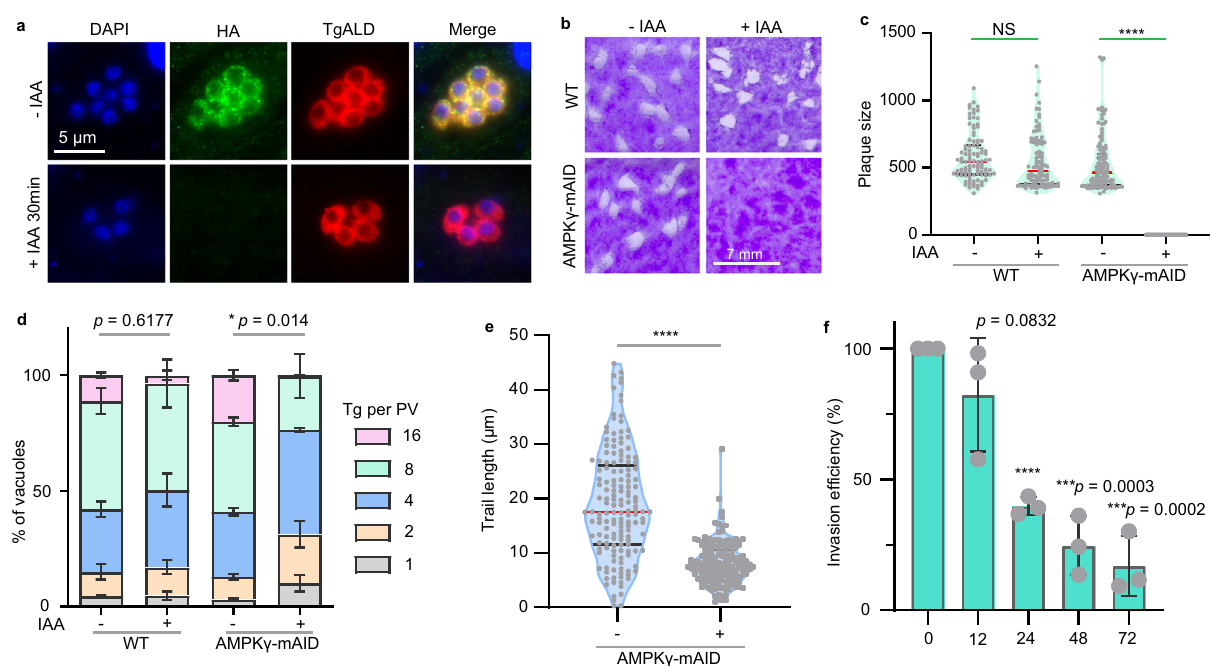
Fig.2|AMPK γ isessentialforthegrowthof Toxoplama tachyzoites.a Depletion of TgAMPK γ in the AMPK γ -mAID strain by IAA treatment, asdetermined by IFA on intracellular parasites treated with or without IAA. The anti-HA antibody was used to probe the levelofAMPK γ and TgALD was used as cytoplasmicmarker. b Lackof parasite growth after TgAMPK γ depletion, as determined by plaque assays with or without IAA treatment for 7days. c Relative sizes of plaques (expressed as pixel units when calculated from Adobe Photoshop) derived from b . More than 90 pla- ques were determined for each condition and the data are graphed as violin plots (median with interquartile range). ****P <0.0001, NS ( p =0.1604): not signi fi cant, unpaired two-tailed Student ’ s t -test. d Intracellular replication rates of indicated strains with or without IAA treatment, as determined by the distribution of para- sitophorous vacuoles (PVs) containing 1, 2, 4, 8 or 16 parasites after 24h of intra- cellular growth. Means±SEM of n =3 independent experiments, each with two technicalreplicates,two-wayANOVAwithTukey ’ smultiplecomparisonspost-tests. e The length of trails formed by extracellular parasites gliding on bovine albumin